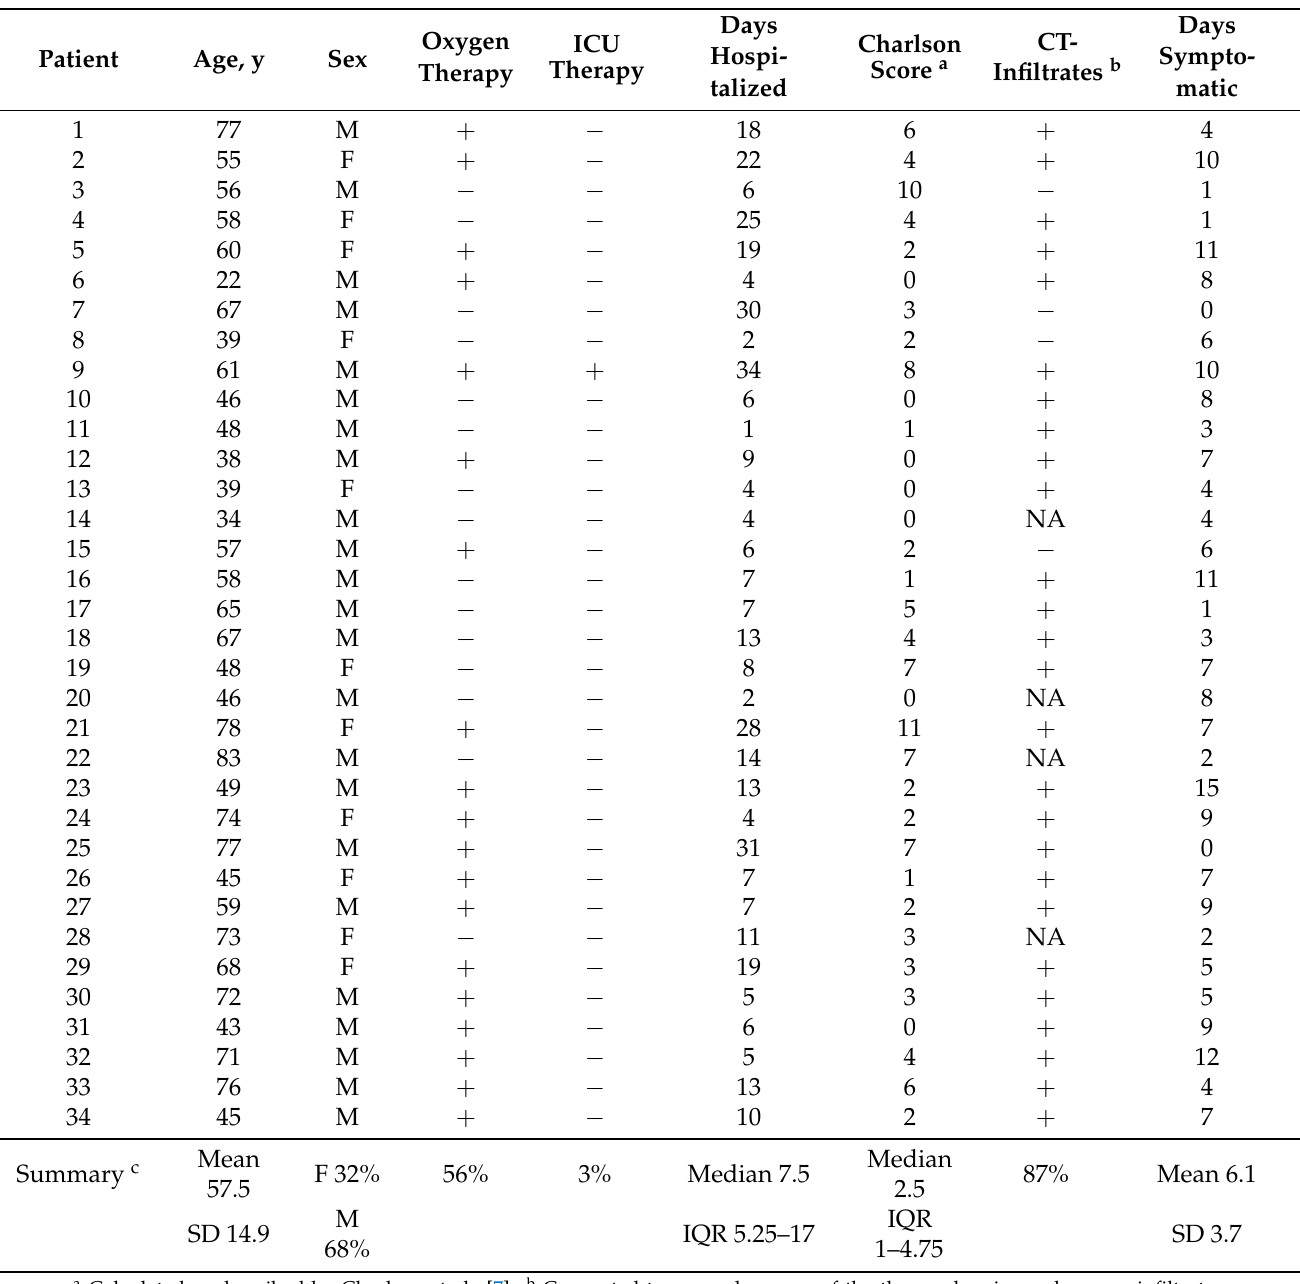
Table 1. Demographic and Clinical Details of the Study